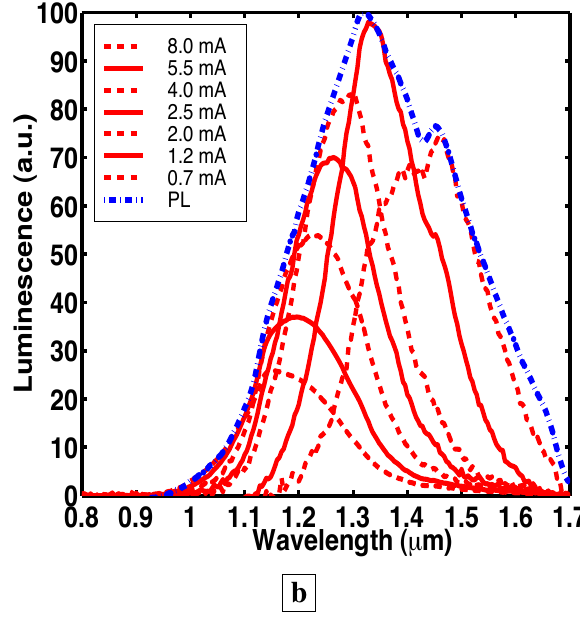
Figure 5 . Characteristic absorption length of the optical pump and inhomogeneous broadening of the PL [7]. a, The excitation laser creates minority holes throughout the deep-center layer because the characteristic absorption length of the laser is greater than the deep-center layer thickness. b, PL spectrum (dashed-dotted line), on top of which is superimposed several normalized EL spectra (solid and dashed